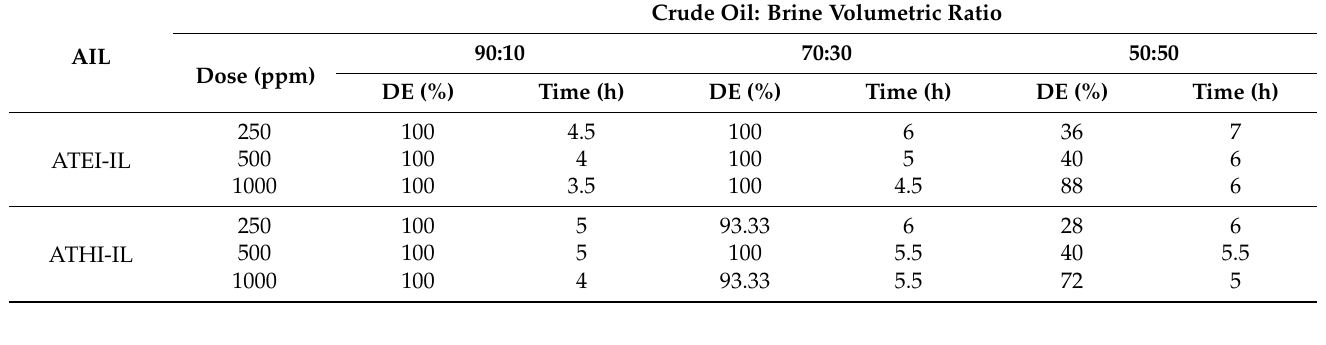
Table 2. Demulsification efficiency of ATEI-IL and ATHI-IL different concentrations.